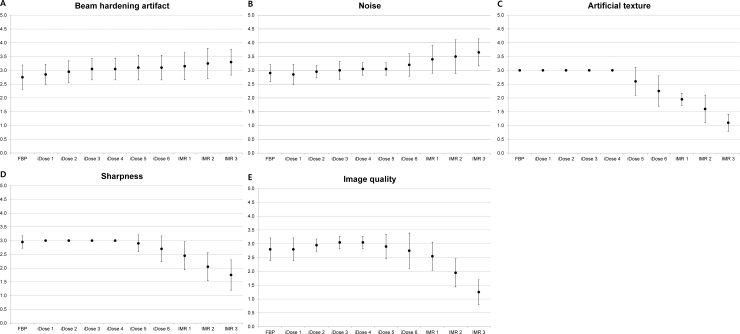
Graphs illustrating qualitative scores of each reconstruction set of the reduced-dose CT.All reduced-dose CT images were scored compared to the standard-dose CT images (e.g., 3: similar to the standard-dose CT). Higher score indicates a better image quality. (A) Beam hardening artifacts and (B) subjective image noise decreased as iDose and IMR levels increased. However, iDose levels of 5 and 6, and all IMR levels negatively affect (C) artificial texture and (D) margin sharpness. (E) Overall image quality was highest with iDose levels of 3 and 4.